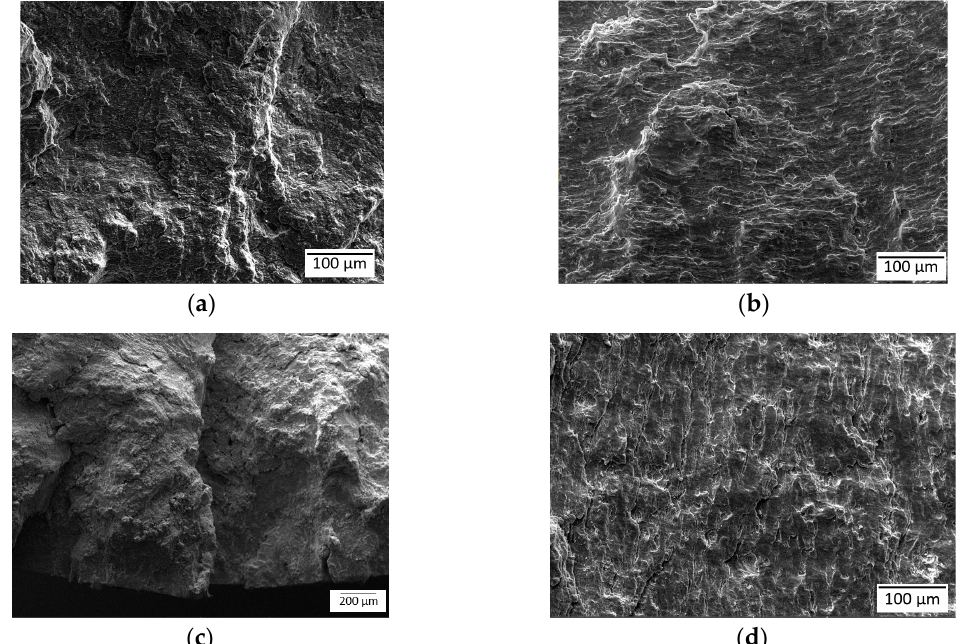
Figure 16. SEM micrographs of the fracture surfaces for different total strain ranges at 620 °C ( a ) LCF ± 0.23%, ( b , c ) LCF ± 0.4%, ( d ) RF ± 0.4%; ( a , b , d ) were taken at the central part of the fracture surface, ( c ) was taken at the edge of the fracture surface.